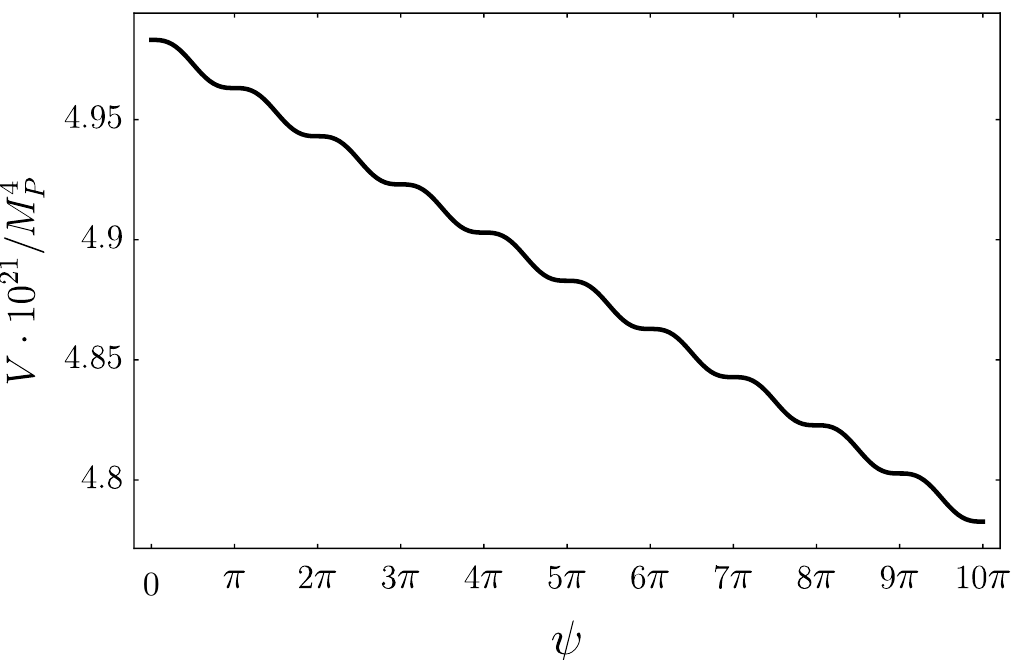
Figure 2 . The in(cid:13)aton potential as a function of the 5-brane position on the S 3